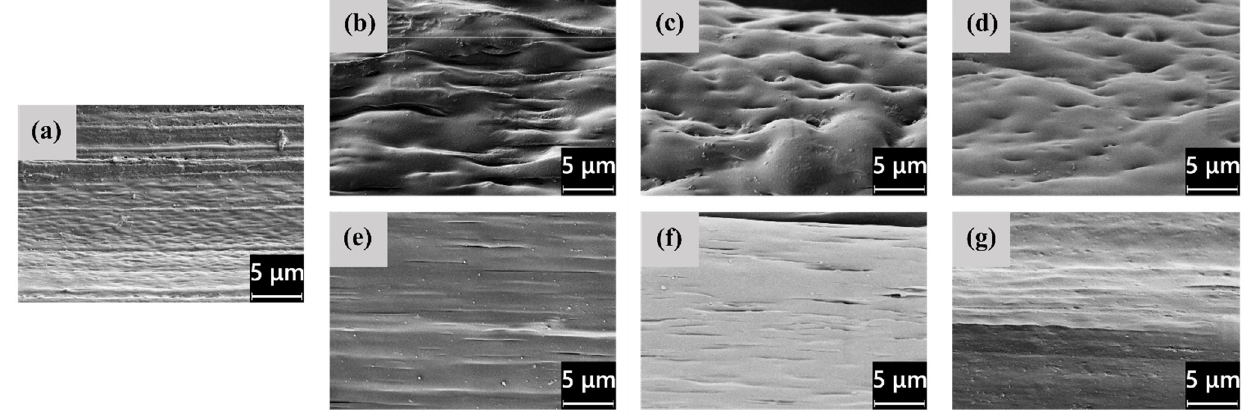
Figure 4. FESEM micrographs of the cryo − fractured cross − section of the as − spun fibers: ( a ) PLA, ( b ) PEF − 2.5% − as, ( c ) PEF − 5% − as, ( d ) PEF − 10% − as, ( e ) PDoF − 2.5% − as, ( f ) PDoF − 5% − as, ( g ) PDoF − 10% − as.